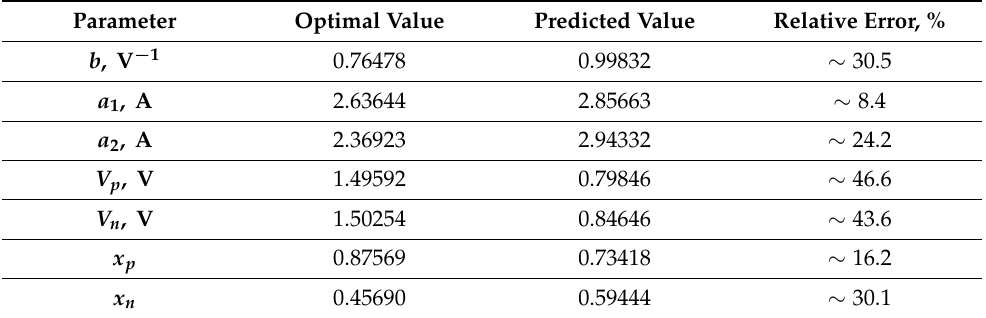
Table 4. Result of machine learning model application and comparison with parameters obtained with optimization.